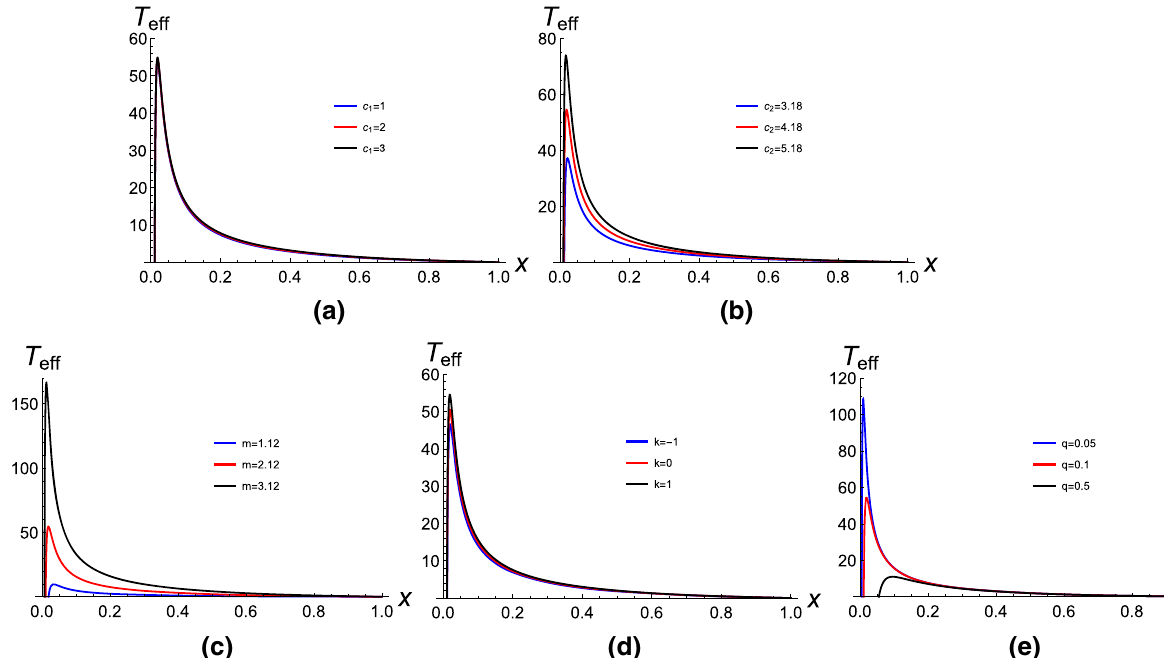
Fig. 2 T ef f − x diagrams when the parameters change